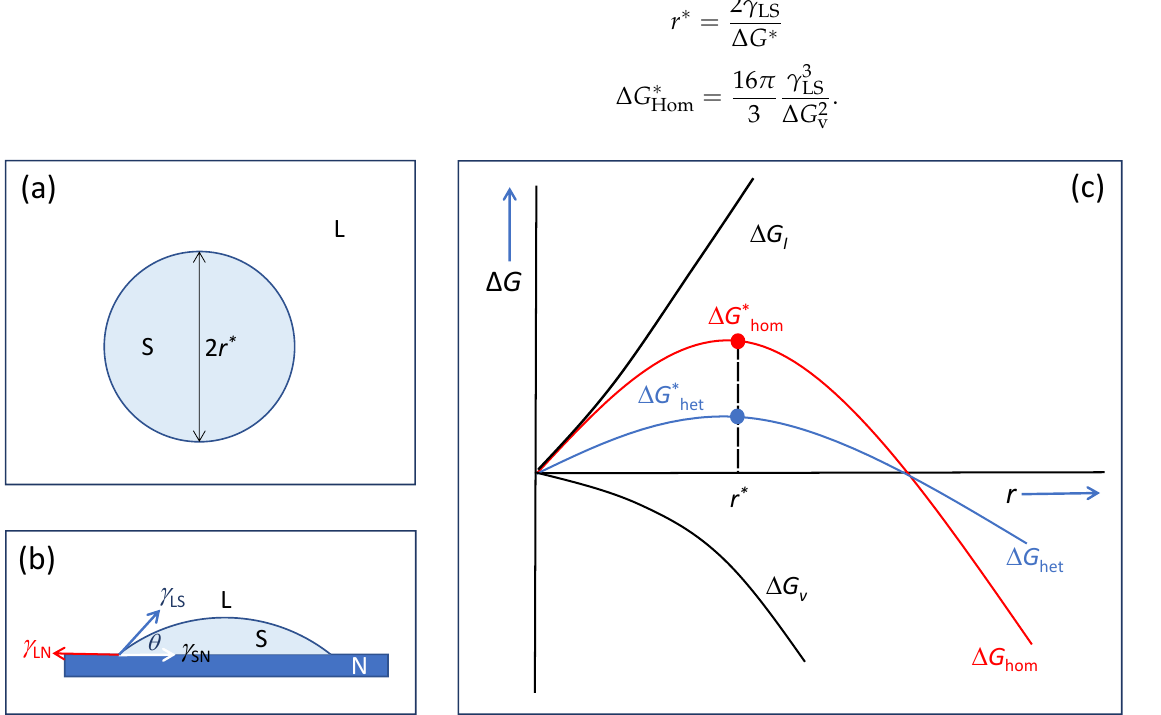
Figure 1. Schematic illustration of the classical nucleation theory (CNT). ( a ) Formation of the spherical nucleus of the solid (S) with a critical radius of r * from the liquid (L) during homogeneous nucleation; ( b ) formation of spherical solid cap on a substrate (N) with a wetting angle of θ during heterogeneous nucleation; and ( c ) free energy change (Δ G ) as a function of cluster size ( r ) showing the formation of nuclei ( r *) during homogeneous and heterogeneous nucleation processes by overcoming the energy barriers (Δ G * hom , Δ G * het ), which is a consequence of balancing the interfacial energy change (Δ G i ) and volume free energy change (Δ G v ).